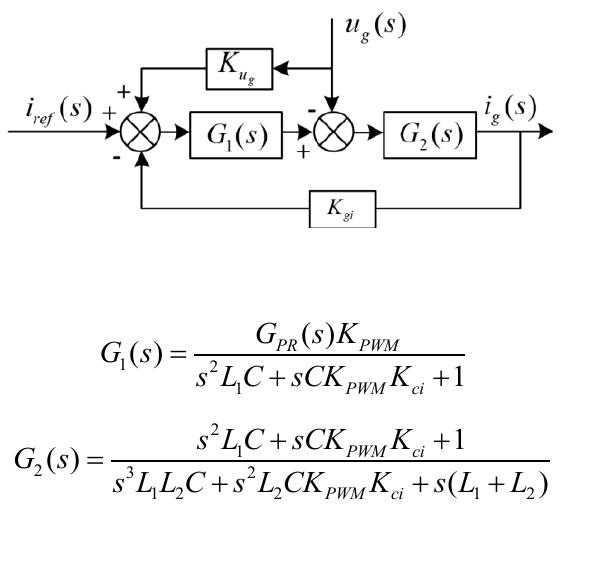
Figure 4. Equivalent control